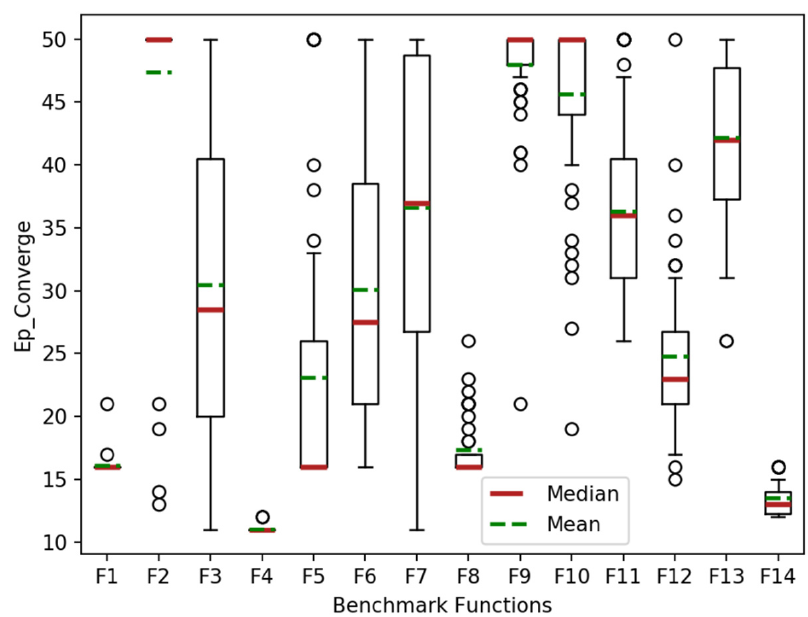
Figure 2. This box plot shows the convergence pattern of SPGD-C4.